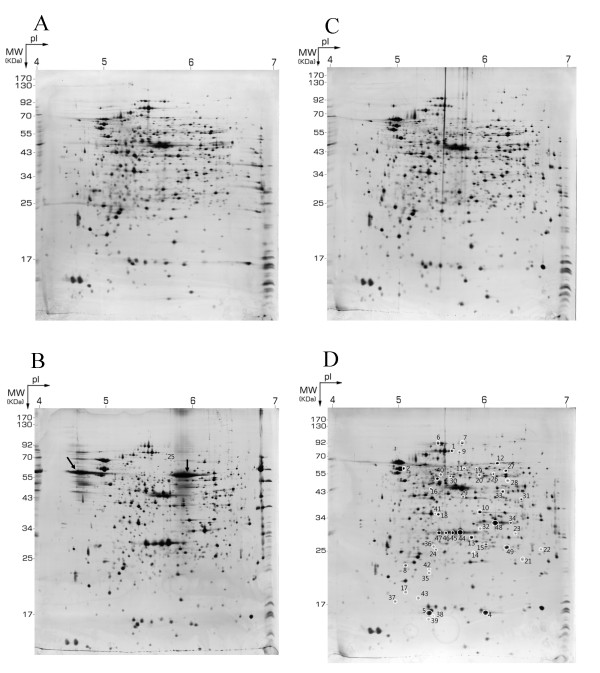
Representative 2-DE gels of E. coli BL21 plasmid-bearing strains. Two-dimensional gel electrophoresis (2-DE) of the cell lysates of E. coli BL21 harboring pGEX-2TK-nanA-5R (A, B) and E. coli BL21 harboring pGEX-2TK-2ep-5D (C, D) harvested before (A, C) and after 3-h IPTG induction (B, D). Numbers on the gels reflect the identified protein spots as denoted in Table 1.